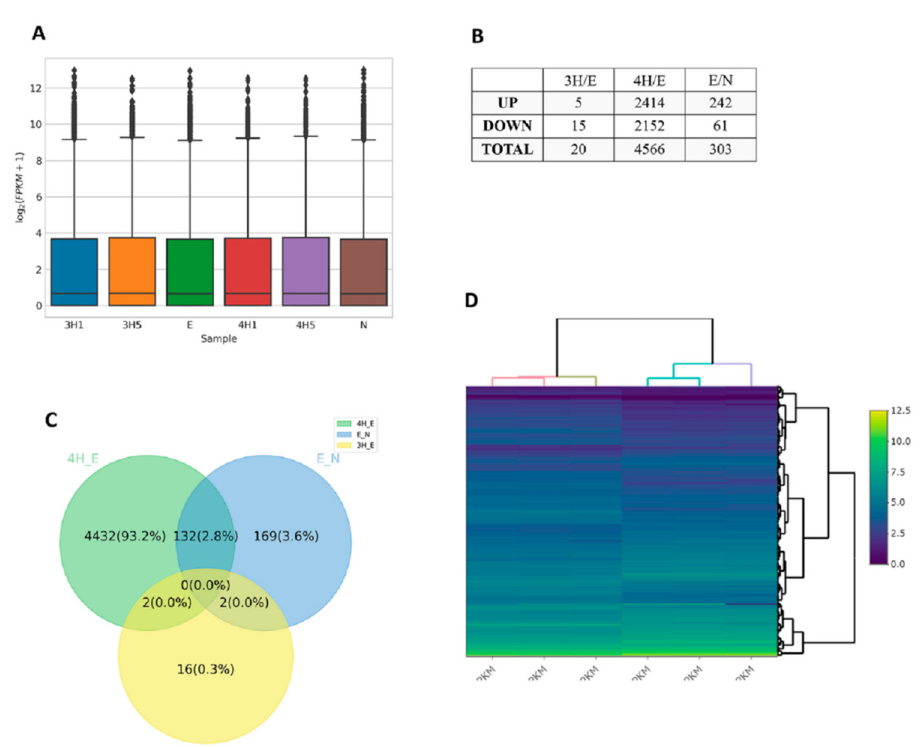
Figure 1. Summary of the transcriptome profile of mouse brain astrocytes after excretory/secretory product or benzaldehyde treatment. ( A ) Boxplot of FPKM distribution among samples. N: